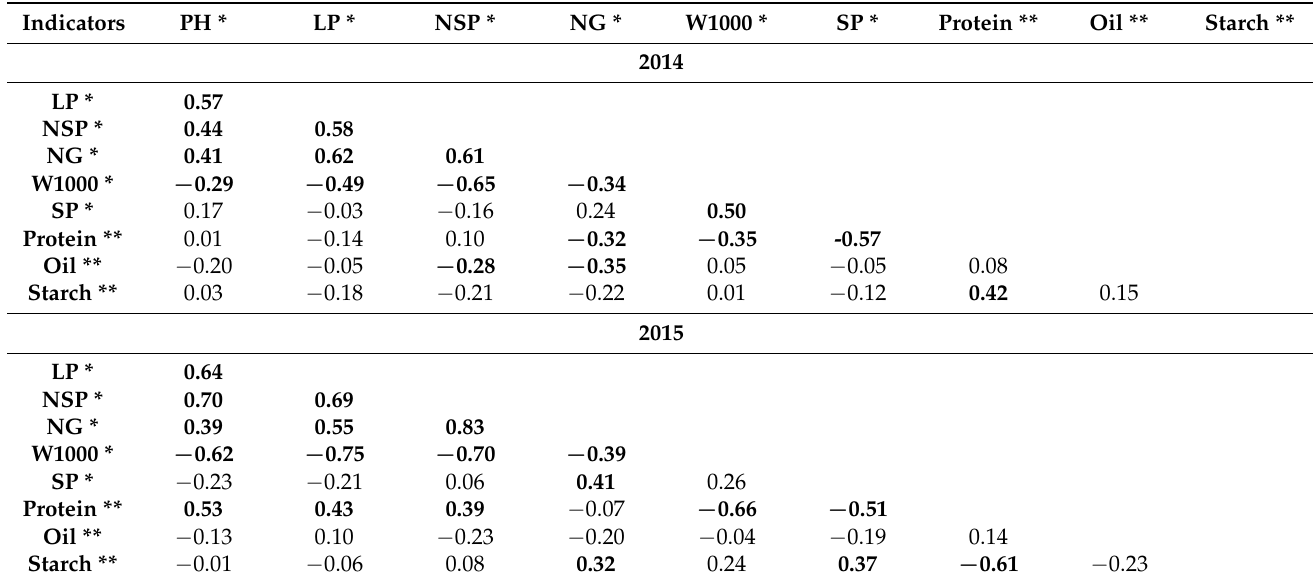
Table 3. Correlation coefficients between useful agronomic characters and biochemical indicators in the grain of Avena L. species accessions from the VIR collection in 2014–2015.